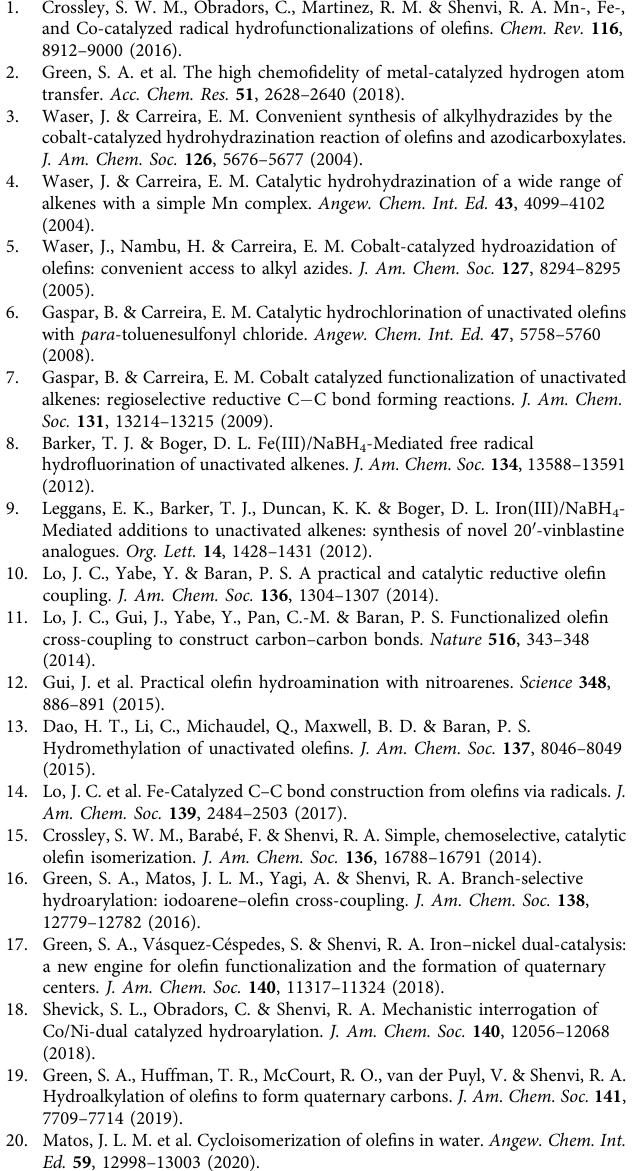
alkenes are currently in progress in our group.